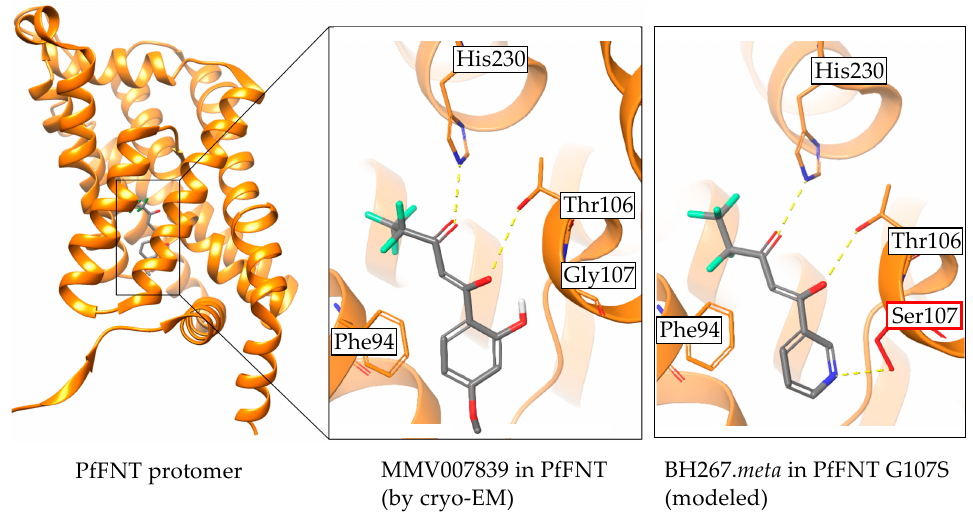
Figure 7. Confirmation of the binding mode of PfFNT inhibitors by cryo-electron microscopy. Visualization of MMV007839 bound to PfFNT was done using PDB# 7e27 with the Maestro software (Release 2021-3; Schrödinger, New York, USA). The display of BH267.meta in PfFNT G107S was generated with the Protein Preparation Wizard and subsequent molecular docking using the standard, ligand centered Induced Fit Docking protocol.